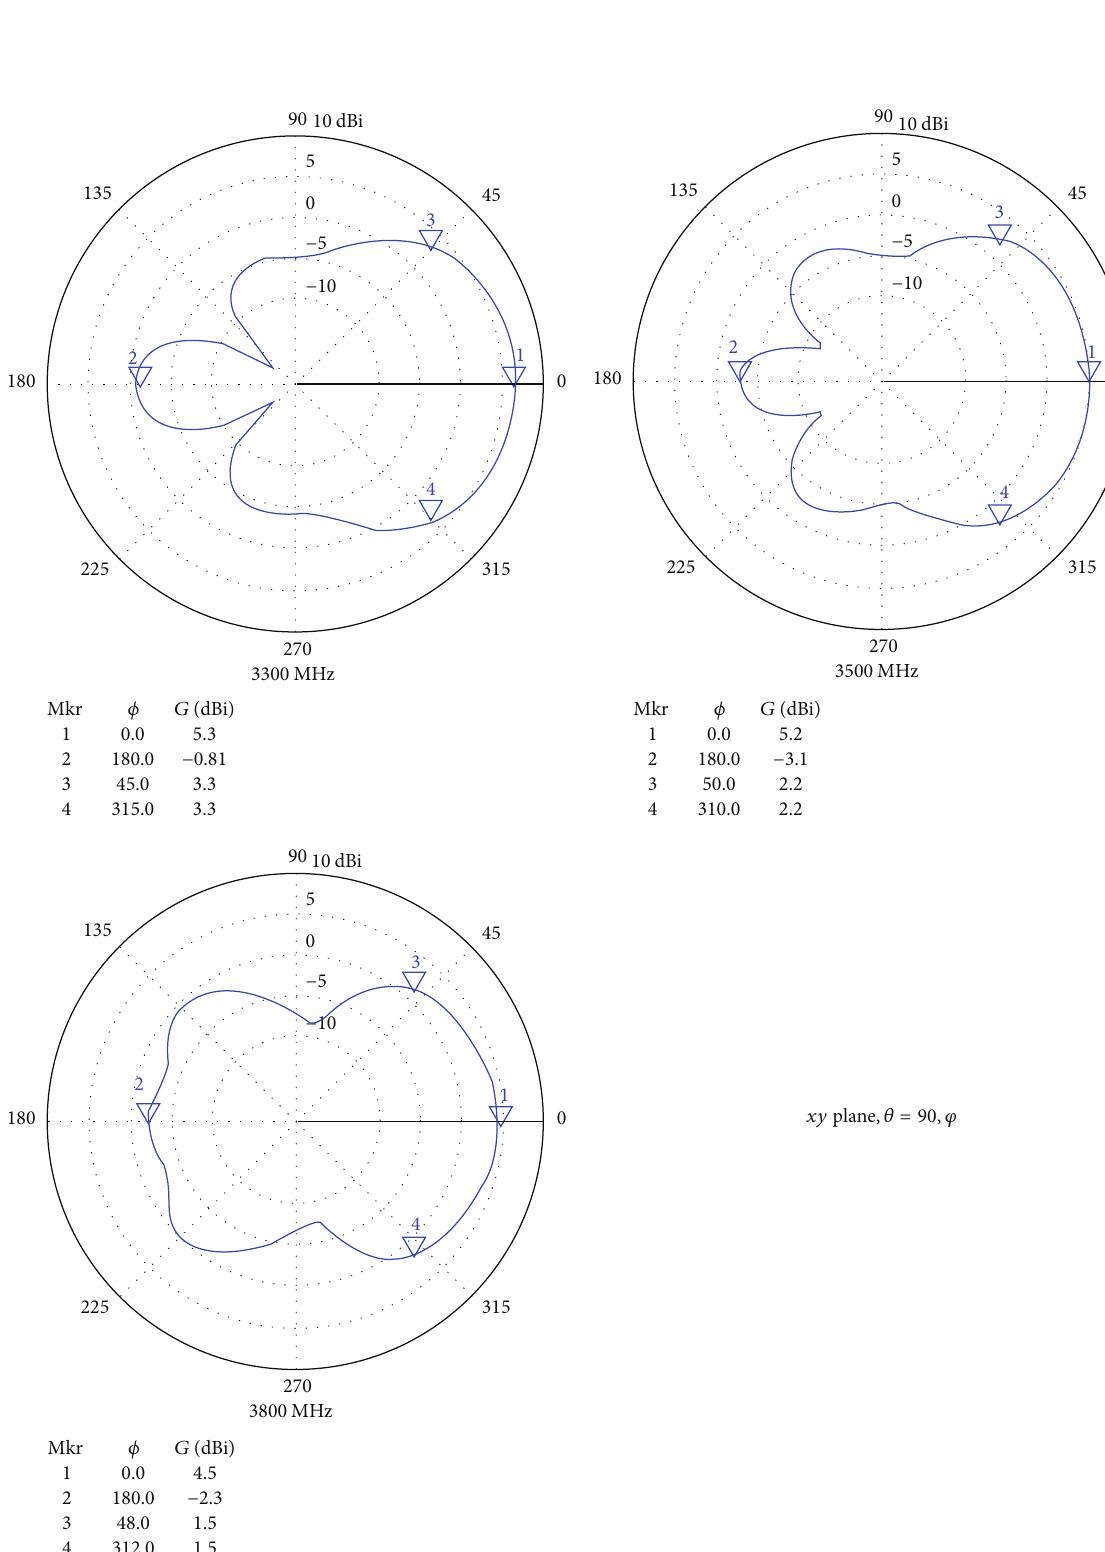
Figure 12: Radiation patterns at 𝑥𝑦 plane for the CSPA at 3300 MHz, 3500 MHz, and 3800